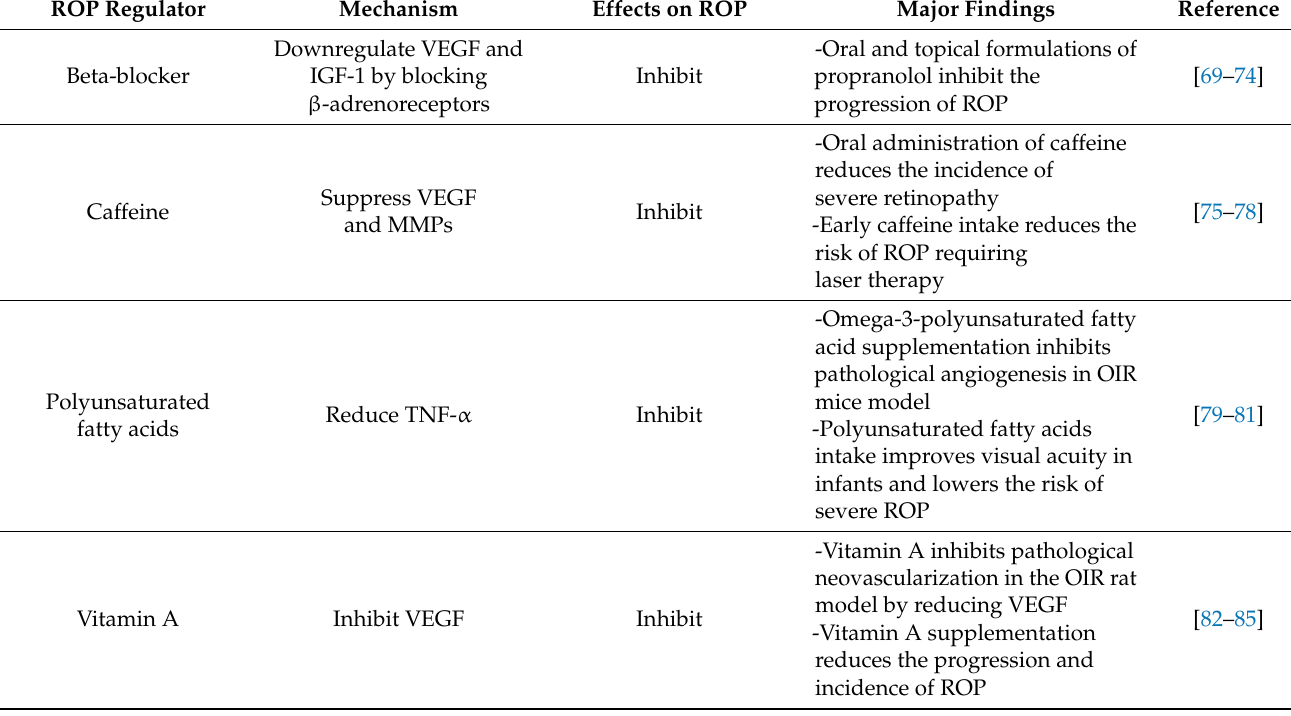
Table 3. The role of ROP therapies under investigation with partially proven